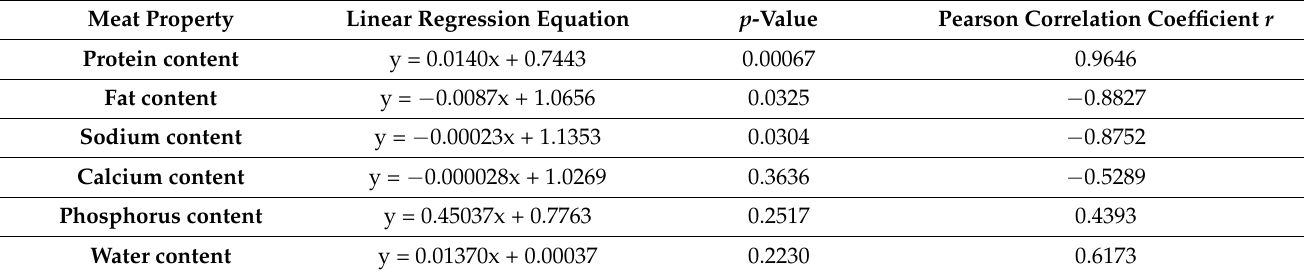
Table 3. Pearson’s coefficients r , p -values and linear regression equations for density ρ versus content of: protein, fat, ( Na ), ( Ca ), ( P ) and ( H 2 O